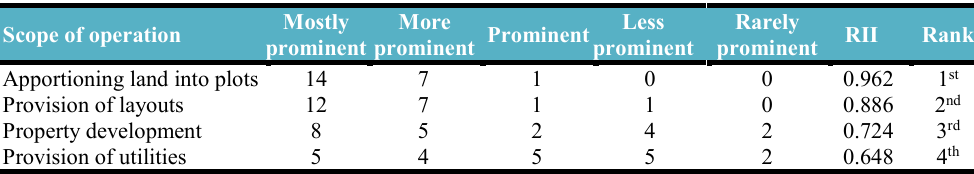
Table 4. Scope of Operation of Land